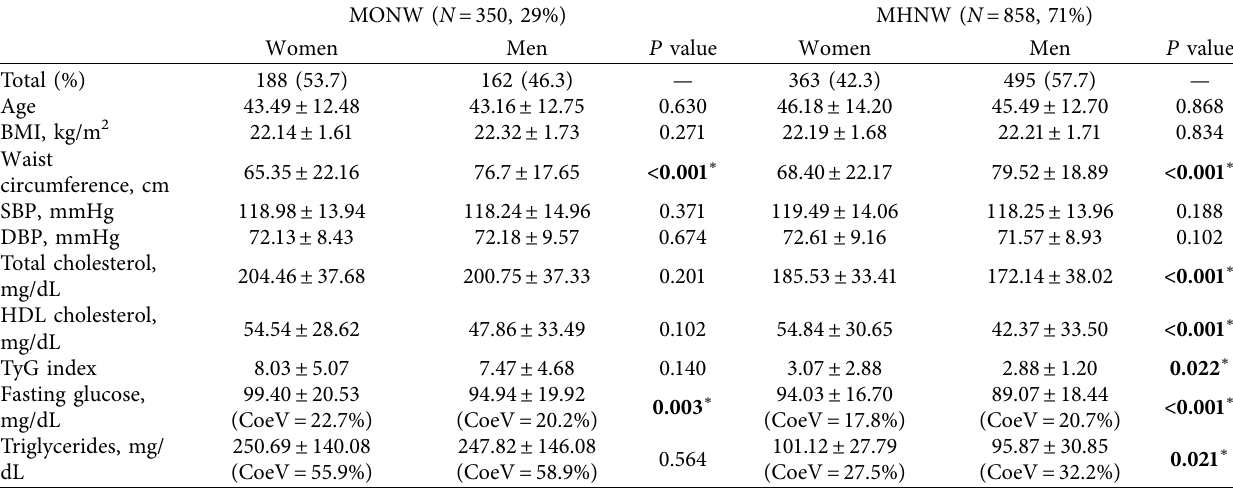
Table 1: Characteristics of the study population stratified by sex ( n � 1208).